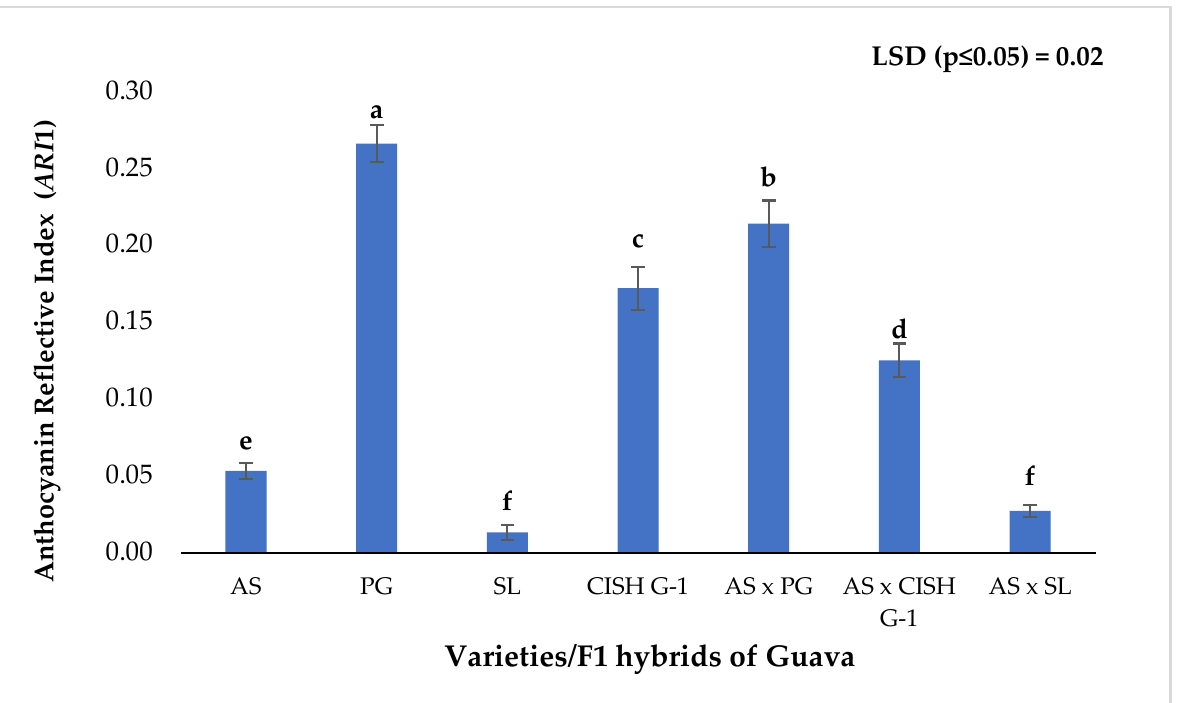
Figure 2. Leaf-colouration traits of F1 hybrids and their respective parents. AS = Allahabad Safeda, PG = Purple guava (local), SL = Seedless, CISH G-1 and their F1 individuals. LSD 0.05 = Least significant difference at α < 0.05, Different letters depict significant differences ( p < 0.05) according to Tukey’s honest significance test.